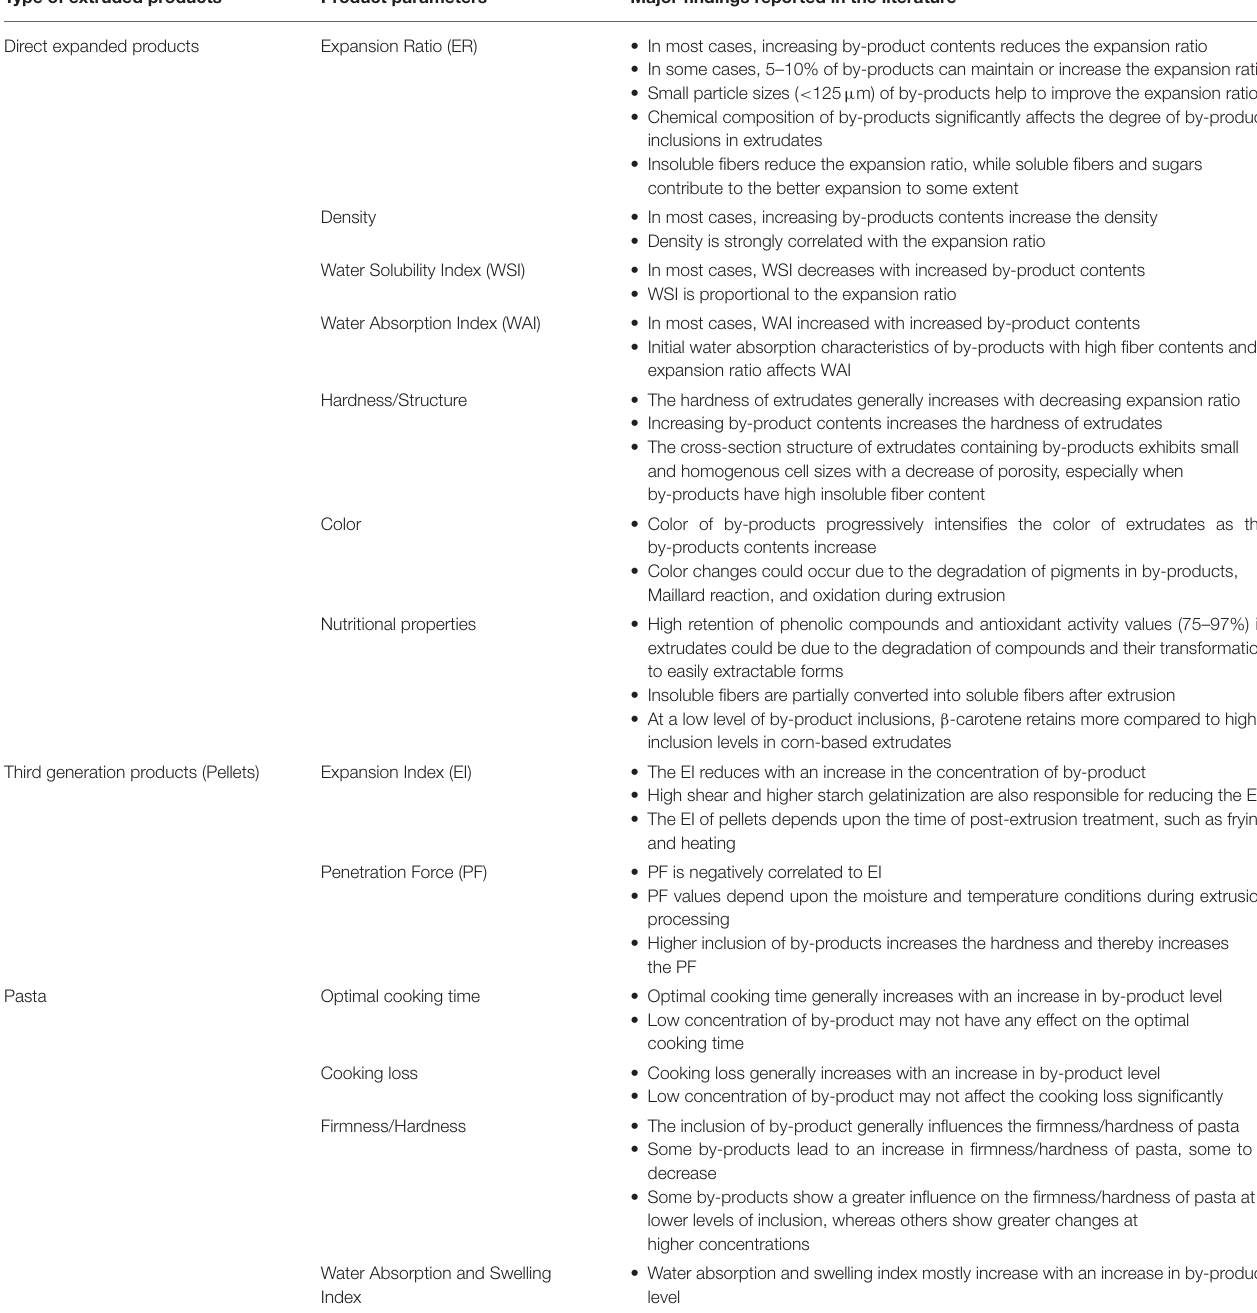
TABLE 3 | General effects of by-product inclusion on extruded product characteristics. Type of extruded